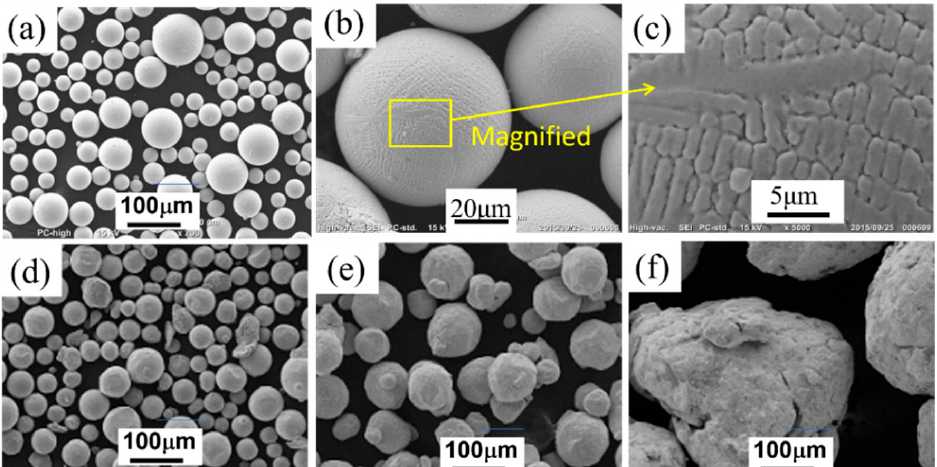
Figure 1. Scanning electron microscopy (SEM) images of Inconel 718 PA powder used in electrical resistivity and impedance measurements: ( a ) Virgin powder; ( b ) Magnified image of virgin powder; ( c ) Surface morphology of virgin powder; ( d ) Powder after ball milling for 10 min; ( e ) Powder after ball milling for 30 min; ( f ) Powder after ball milling for 60 min.